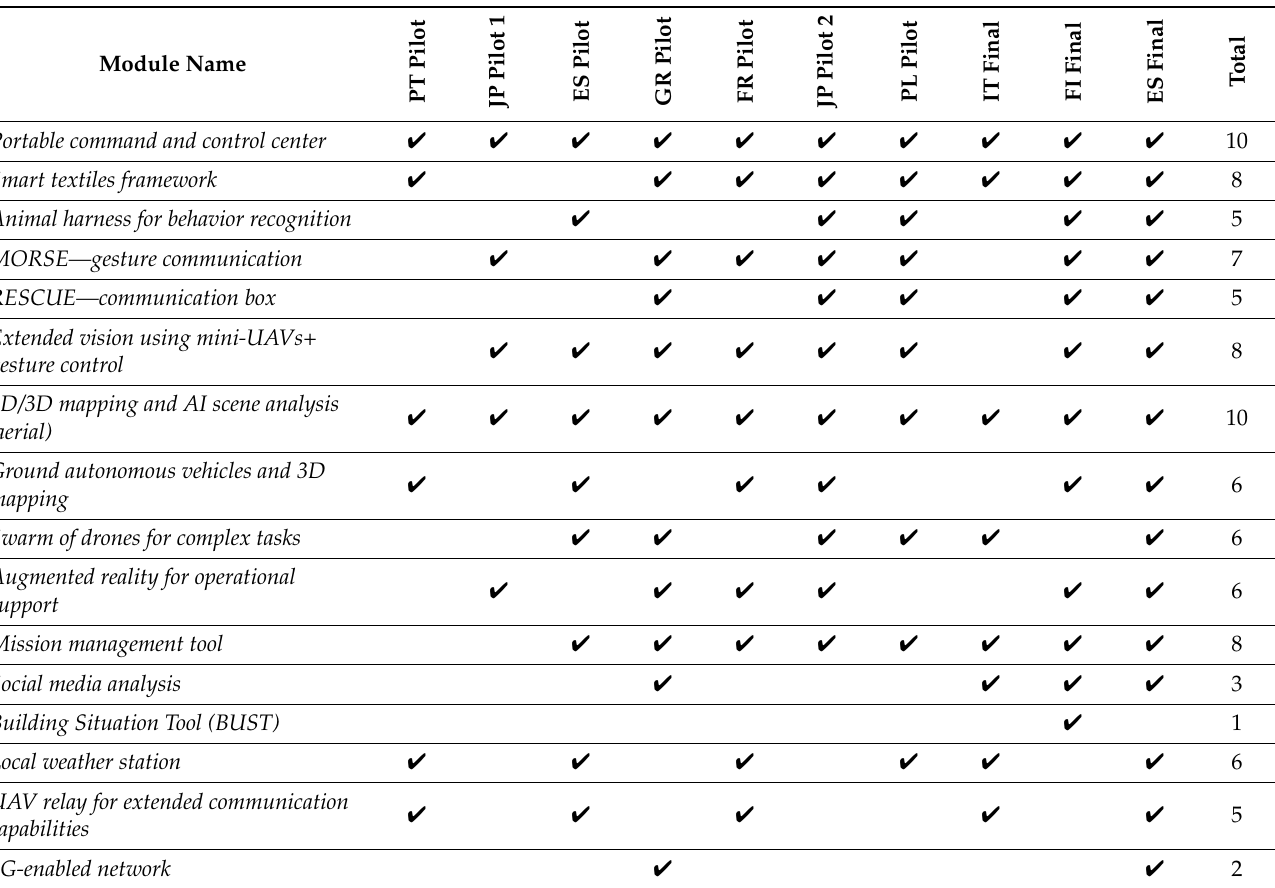
Table 2. Participation List of FASTER tools in piloting activities for evaluation.